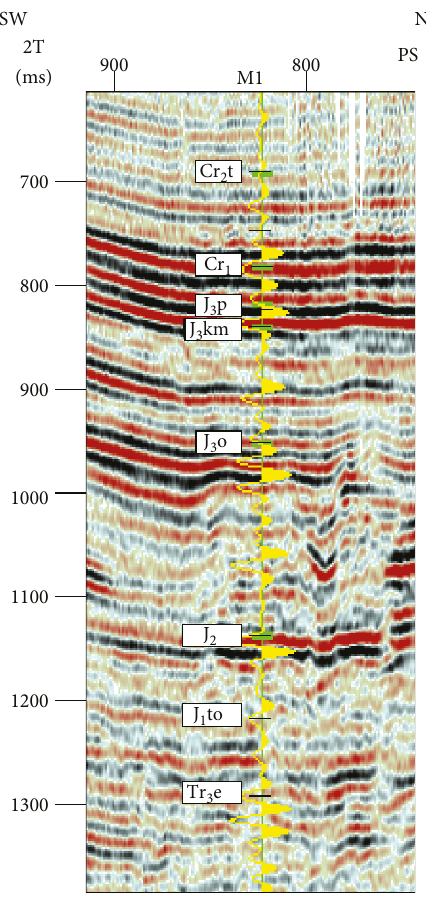
Figure 4: Correlation of synthetic seismogram (yellow trace) for M1 well with the true seismic section (red and black colour — negative and positive true seismic re fl ections, respectively) in the Lower Cretaceous and Lower Jurassic geothermal reservoir intervals (orange part of line in Figure 3). Explanations of seismic horizons: Cr t: top of the Turonian; Cr : top of the Lower Cretaceous; J p: 2 1 3 km: top of the Kimmeridgian; J o: top of top of the Portlandian; J 3 3 the Oxfordian; J : top of the Middle Jurassic; J to: top of the Lower 2 1 Jurassic (Toarcian); T re: top of the Triassic 3